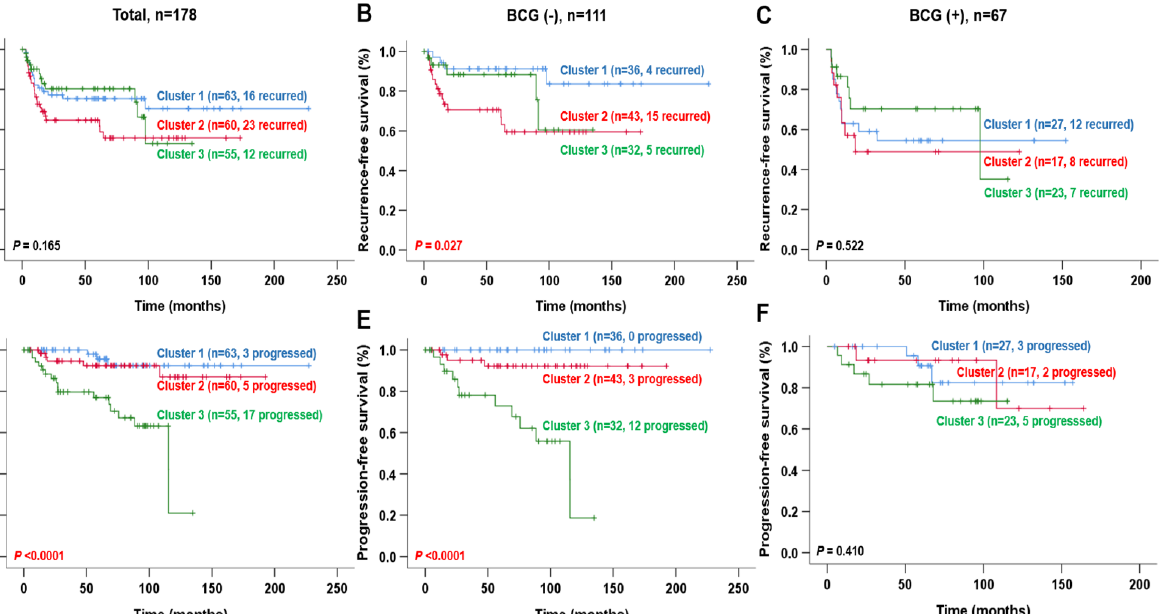
Table 2. Univariate and multivariate Cox regression analyses to predict recurrence of NMIBC pa- tients in the CBNUH cohort not treated with BCG.